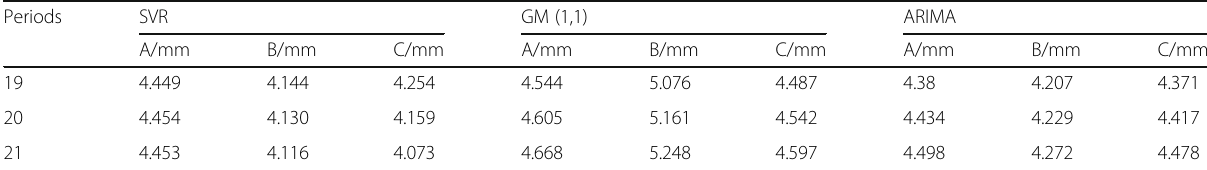
Table 2 Prediction results of single model